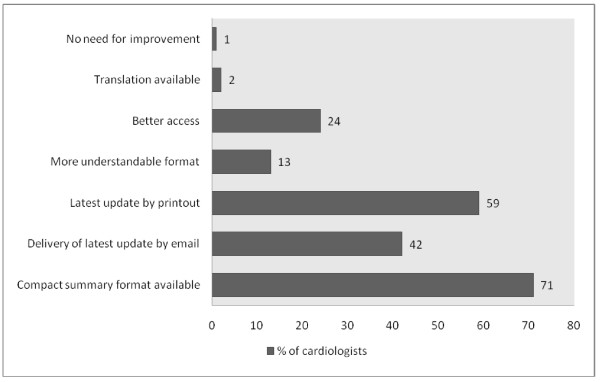
Possible strategies to improve implementation of guidelines.